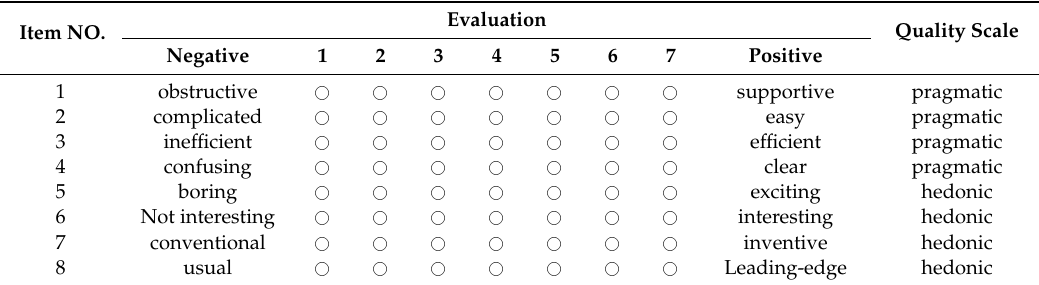
Table 2. UEQ-S evaluation items.